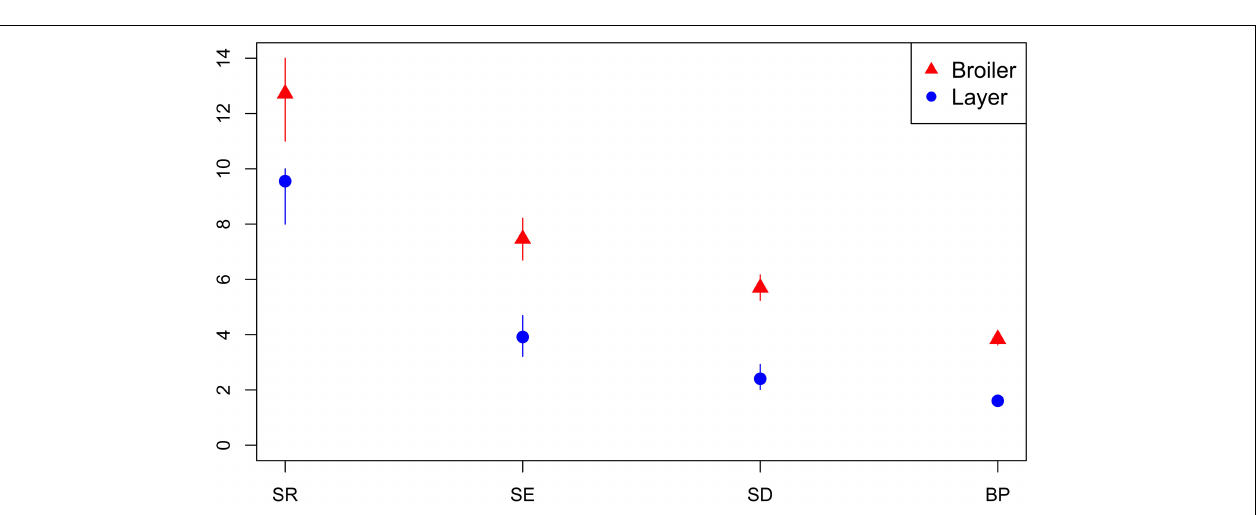
FIGURE 6 | Observed ecological diversities of phenotypic antimicrobial resistance profiles of S. Typhimurium isolates taken from cattle, chickens and pigs between 2003 and 2014. 95% confidence intervals for passive surveillance group indices are indicated by vertical lines.